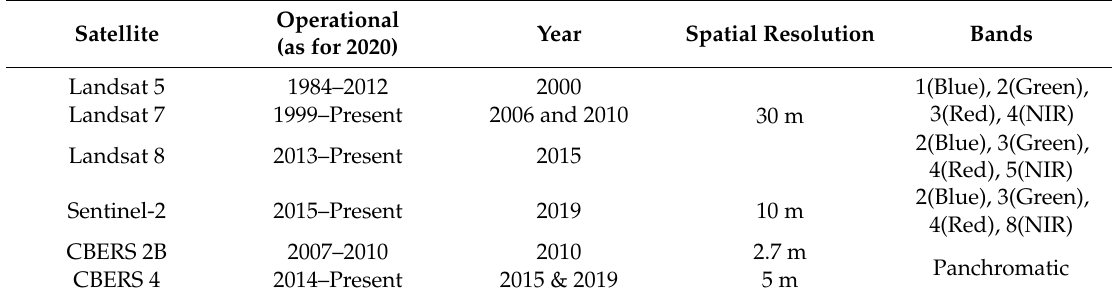
Table 1. Properties of data source satellites. CBERS: China–Brazil Earth Resources